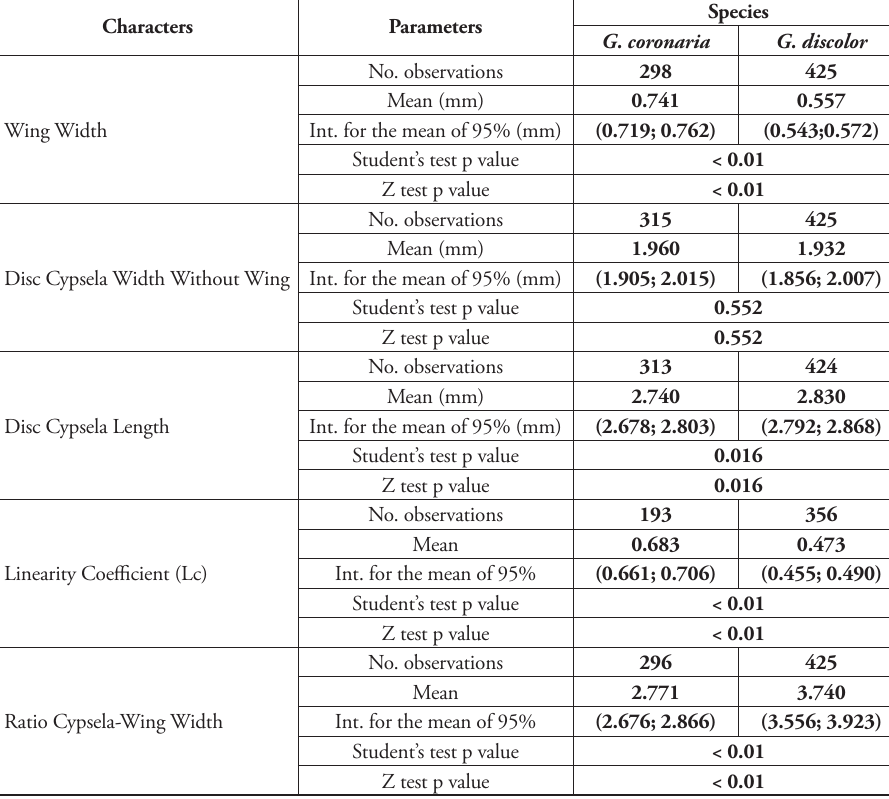
Table 1. Disc cypsela measurements of Glebionis coronaria and G. discolor comb. & stat.